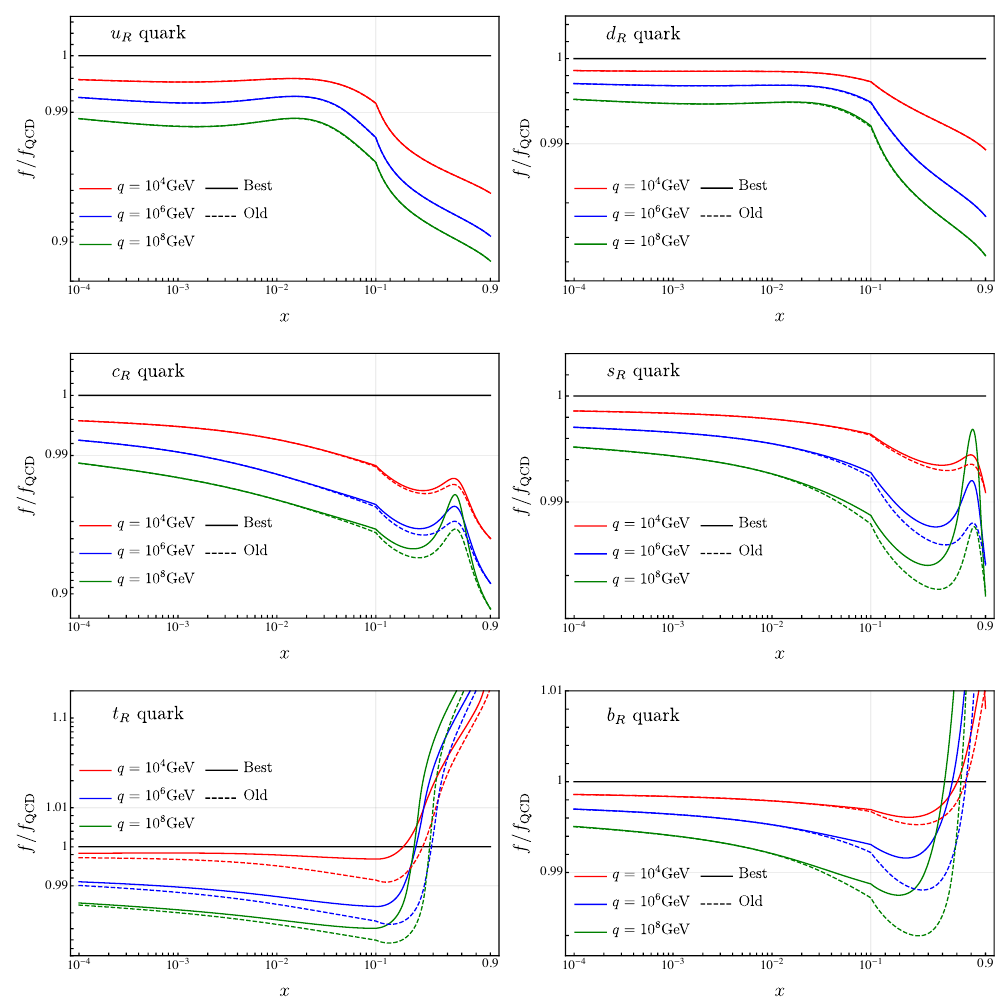
Figure 2 . Right-handed quark PDFs in the full unbroken SM, divided by their values assuming pure QCD evolution only. The thin gray lines show where the scales on the x- and/or y-axes switch between linear and